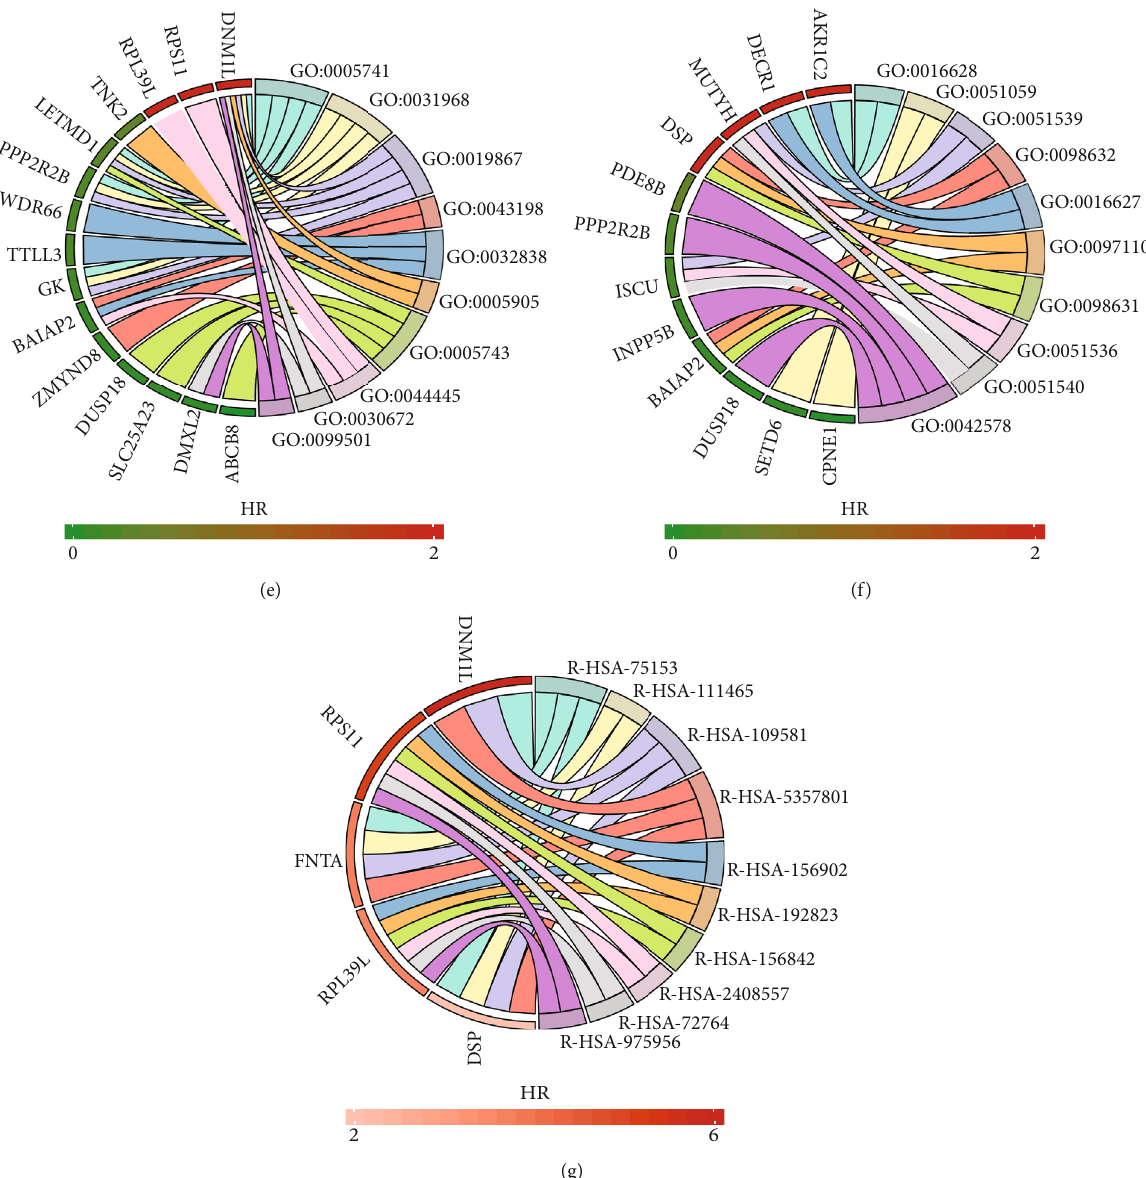
Figure 5: AS clusters associated with prognosis and molecular subtypes: (a) the elbow method identi fi es the optimal number of clusters; (b) the consensus matrix heat map de fi nes two sample clusters, the consensus value of which ranges from 0 (white, samples never clustered together) to 1 (dark blue, samples always cluster together); (c) survival analysis in the two identi fi ed sample clusters; (d – f) top 10 signi fi cantly enriched biological processes, cell components, and molecular functions in GO analysis; (g) top 10 signi fi cantly enriched Reactome